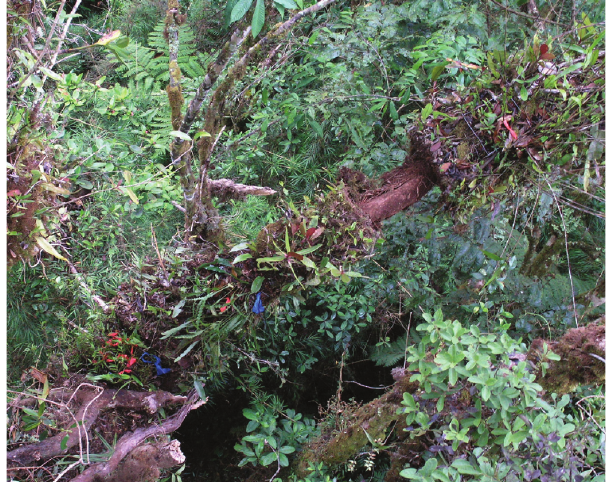
Figure S1. Study branch. Experimental mats in a tree at 1800 m were all on the same large horizontal branch. From lower left to upper right : two mats transplanted from trees at 1500 and 1650 m, an open space awaiting a transplanted mat from 1800 m, and a surveyed undisturbed control